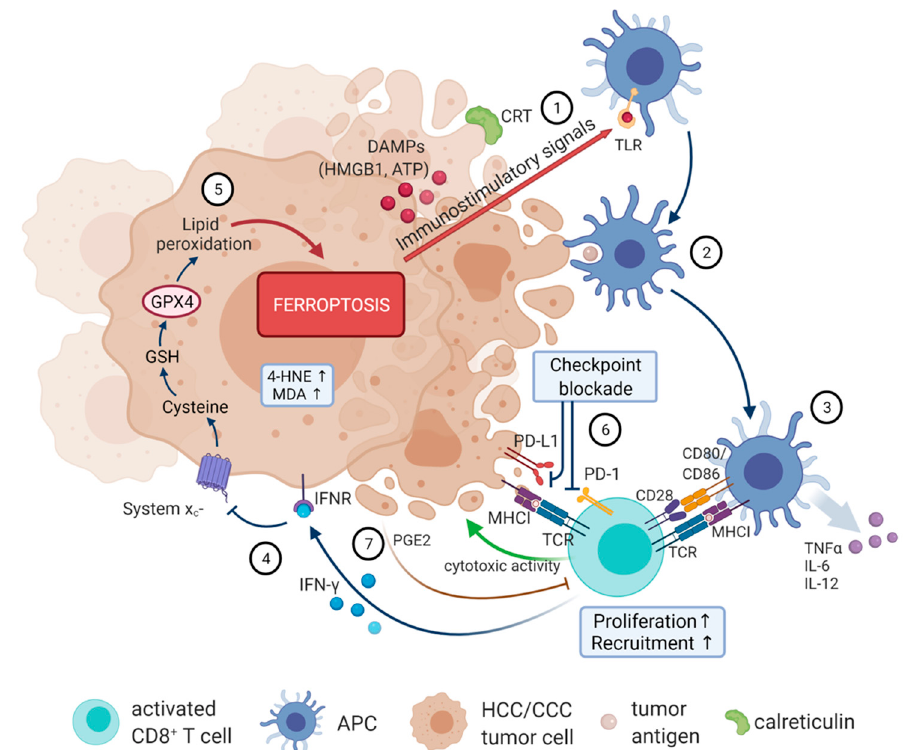
Figure 2. The immunogenic features of ferroptotic cancer cells. Ferroptotic cells release DAMPs, including HMGB1, ATP, and CRT ( 1 ), that act as immune modulators inducing maturation of antigen-loaded DCs ( 2 ). Activated DC release pro-inflammatory cytokines and present TAA to T cells ( 3 ). Activated CD8 + T cells release IFN- γ , activating INFR, which, in turn, downregulates expression of glutamate-cystine antiporter system x c- ( 4 ), and consequently promotes tumor cell lipid peroxidation and ferroptosis ( 5 ). Immune-checkpoint blockade of PD-1 enhances antitumor responses against cancers ( 6 ). Simultaneously, ferroptotic cancer cells release PGE2 that suppresses cytotoxic T